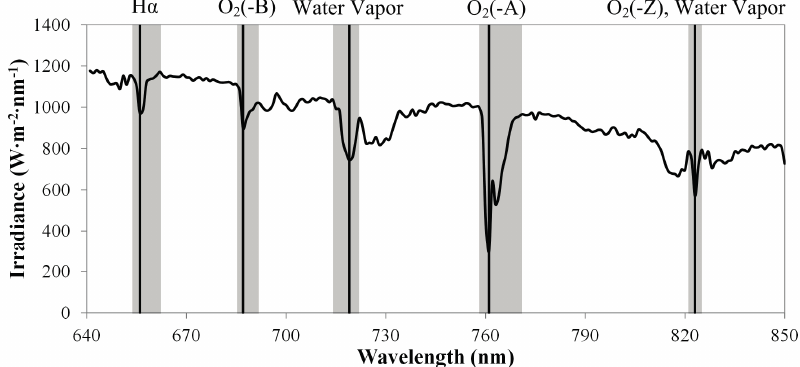
Figure 2. A typical incident solar irradiance spectrum at top of canopy simulated by MODTRAN-5 for a standard mid-latitude summer model atmosphere, and the default rural aerosol model. Both the spectral resolution and spectral sampling interval are 1 nm. Five absorption lines used for Fs retrieval are shown in the figure. Their central wavelengths (spectral positions of the maximum absorption) and spectral ranges are marked with vertical lines and gray shade, respectively, which are further specified in Table 2.